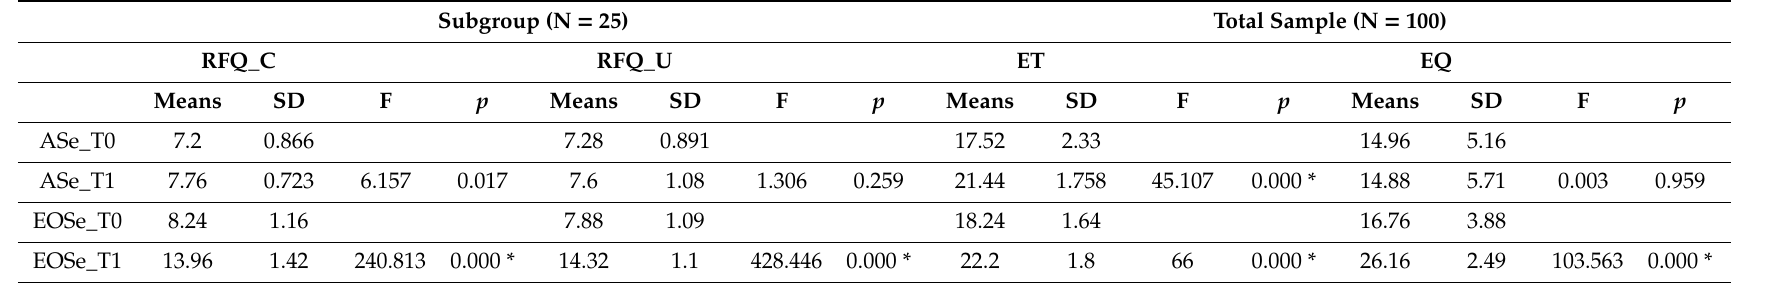
Table 3. Comparison between ASe T0 / T1 (pre / post training) and EOSe T0 / T1 (pre / post